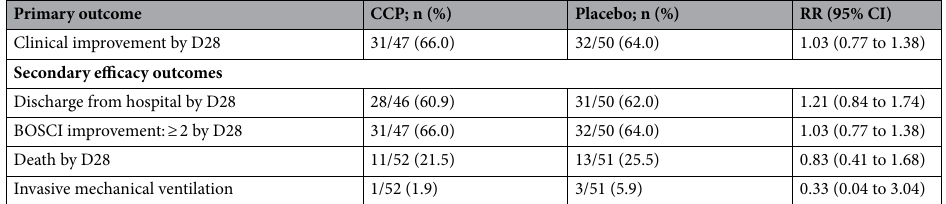
Table 3. Primary and secondary efficacy outcomes in 103 participants with severe COVID-19 randomized to treatment with convalescent plasma versus placebo. Six participants were discharged from primary acute care prior to Day 28 but were lost to follow up as they were uncontactable at Day 28. Clinical improvement is a composite of discharge from hospital and/or improvement in BOSCI score by ≥ 2 by Day 28.